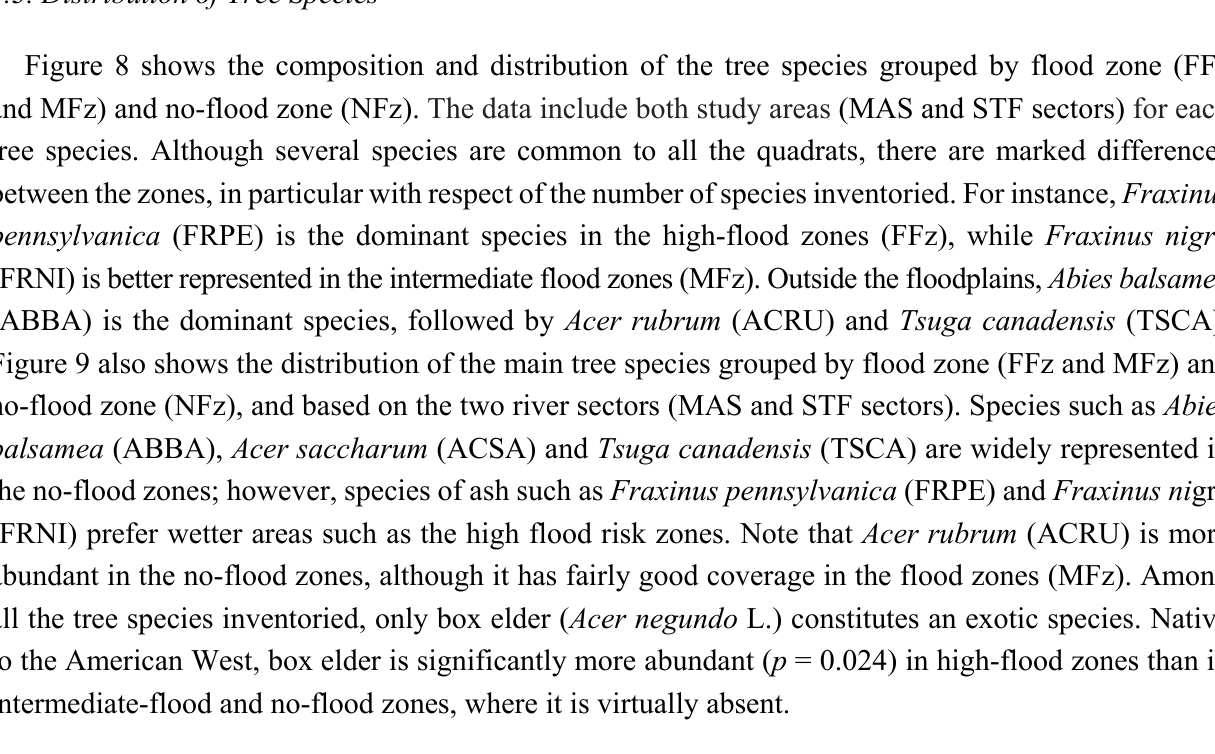
Figure 7. Principal Coordinates Analysis (PCoA) of the tree specimens based on Sørensen’s similarity matrix. The zones of high flood recurrence interval (0–20 years) are represented by black diamonds; zones of intermediate flood recurrence interval (20–100 years) by white circles and zones located outside the floodplains by grey